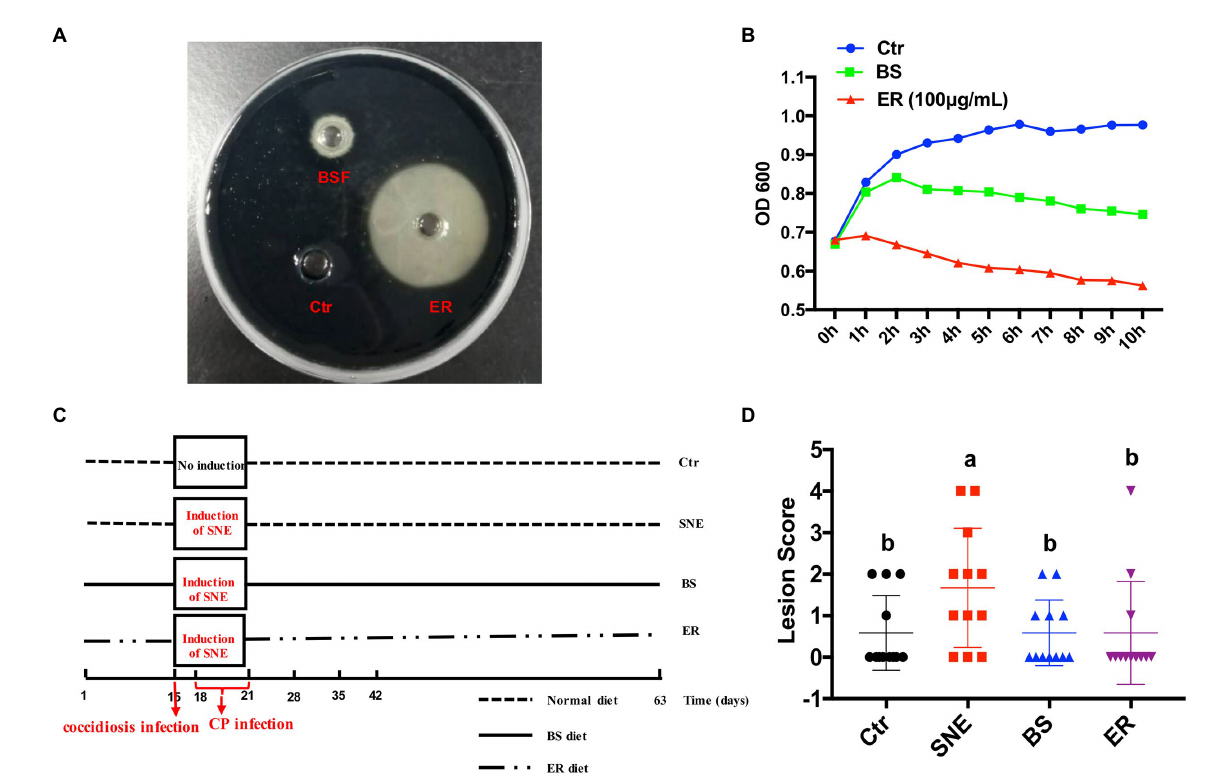
FIGURE 1 (A) In vitro antibacterial activity of BS fermentation supernatant (BSF) against Clostridium perfringen (CP). CP (1 × 10 8 CFU/ml) were cultured in Trptose- sulfite-Cycloserine agar medium and treated with BSF, ER (100 μ g/ml) and sterile Reinforced Clostridial Medium was used as a positive control and negative control, respectively, at 37 ° C. The size of the inhibition zone was observed (B) and analyzed statistically with a line chart. The OD600 kinetics were determined to analyze the effect of BSF against CP. (C) Schematic outline of the experimental design. SNE, subclinical necrotic enteritis. (D) Lesion scores of broilers. (a, b) Mean values with unlike letters between different groups are significantly different ( p < 0·05). SEM, standard error of mean. Each value represents the mean ± SEM of 12 replicates ( n = 12). The abbreviation of Ctr, SNE, BS and ER have the same meaning as Table 3. BSF, BS cell-free